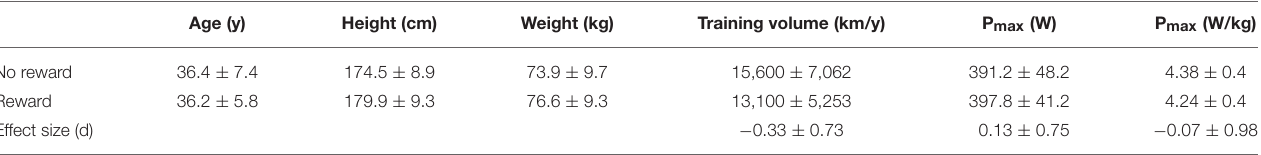
TABLE 1 | Anthropometric and performance characteristics of participants in the rewarded ( n = 11) and the non-rewarded ( n = 12)